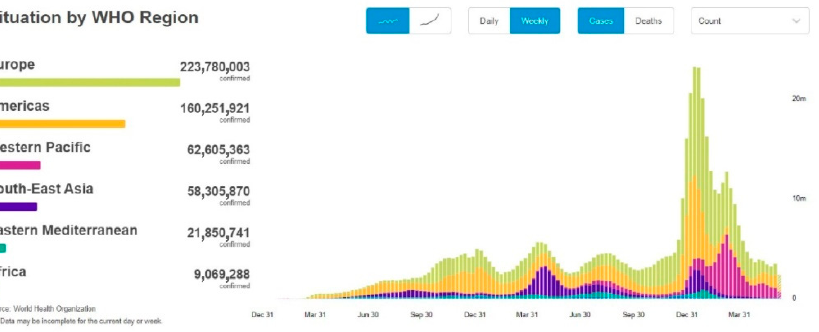
Figure 2. A screenshot of the COVID-19 situation by WHO Region. This dashboard is continually updated and can be accessed at https://covid19.who.int/ (accessed on 17 June 2022).